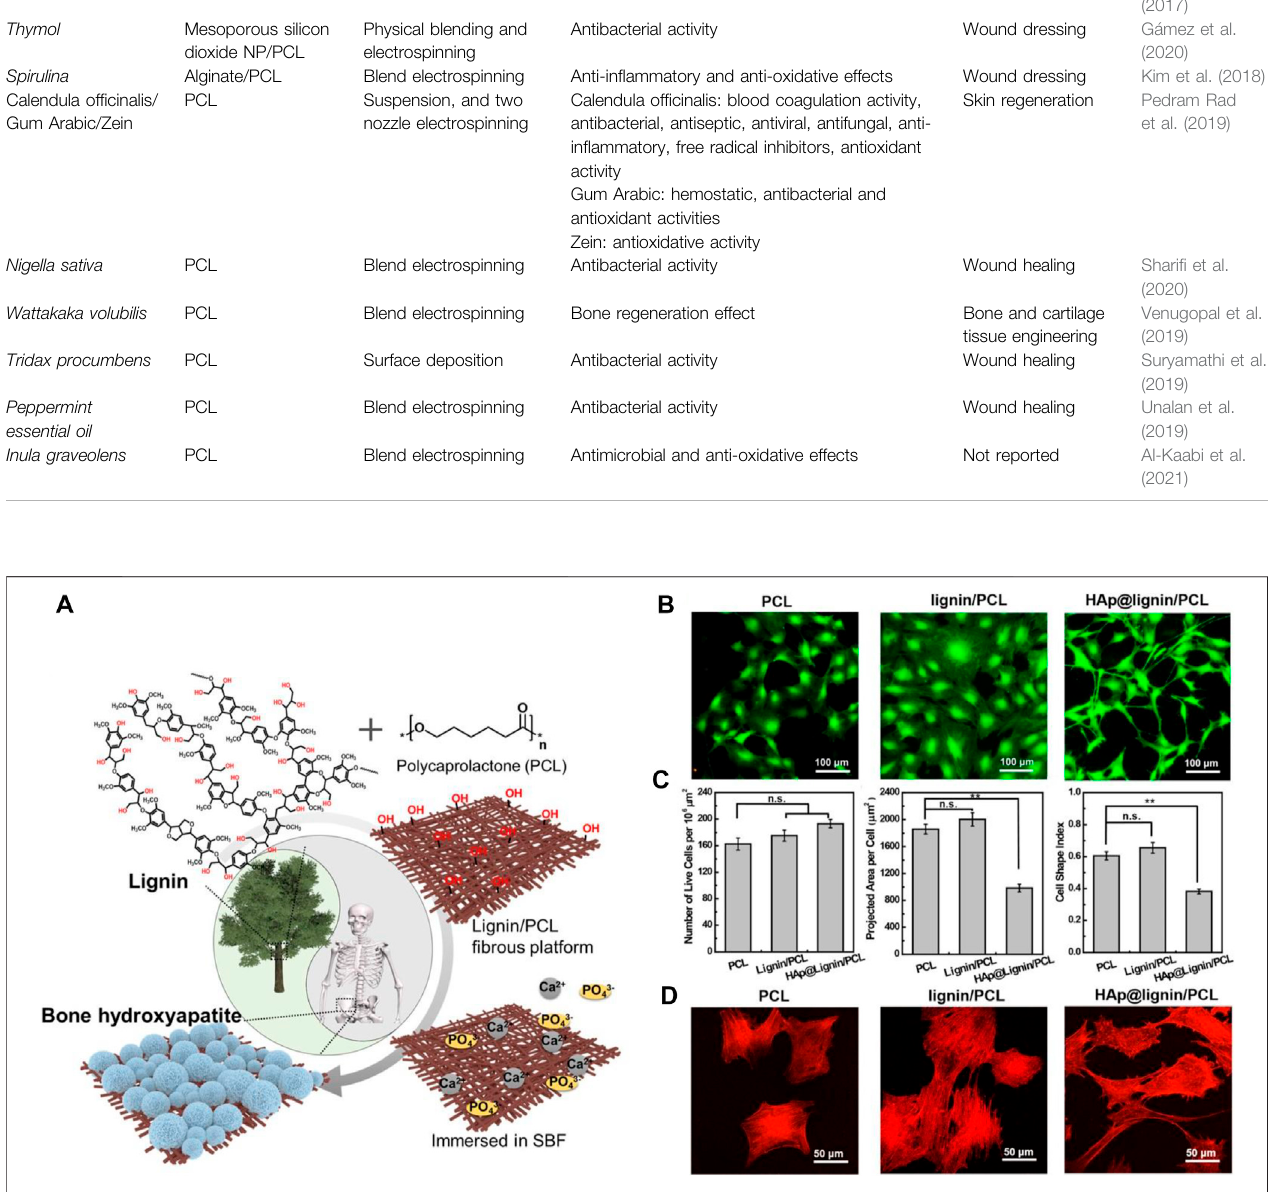
FIGURE 3 | (A) Schematic diagram illustrating the biomineralization process taking place on the surface of lignin/PCL nano fi bers thanks to abundance of hydroxyl groupsthatfacilitatenucleation andgrowthoftheSBF ’ scalciumandphosphate ions. Invitro biocompatibilitytestoftheHA-lignin/PCLnano fi bers,validatedthrough (B) LIVE/DEADassayontheMC3T3-E1cellsafter48 hincubationinthepresenceofthenano fi bers, (C) livecelldensity/10 6 μ m 2 (left),projectedcellarea(middle),Cellshape index (CSI) analysed based on the fl uorescent images (right). The CSI indicates how circular a cell is. It ranges from 0 (linear) to 1 (circle) (** p < 0.01, n. s not signi fi cant). (D) Cytoskeleton con fi guration of the MC3T3-E1 cells present on the nano fi bers. Reproduced with permission. (Wang D. et al., 2019), Copyright 2019, American Chemical